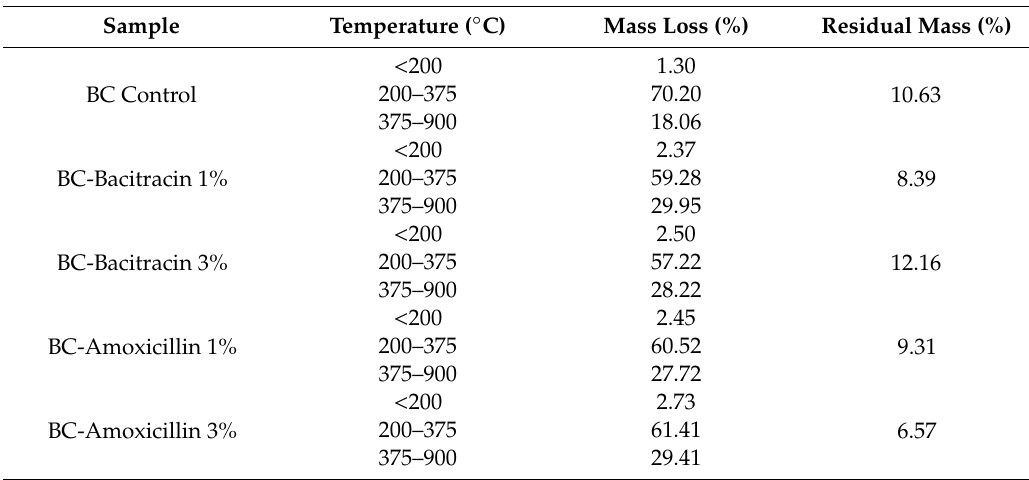
Table 3. Residual mass of samples.